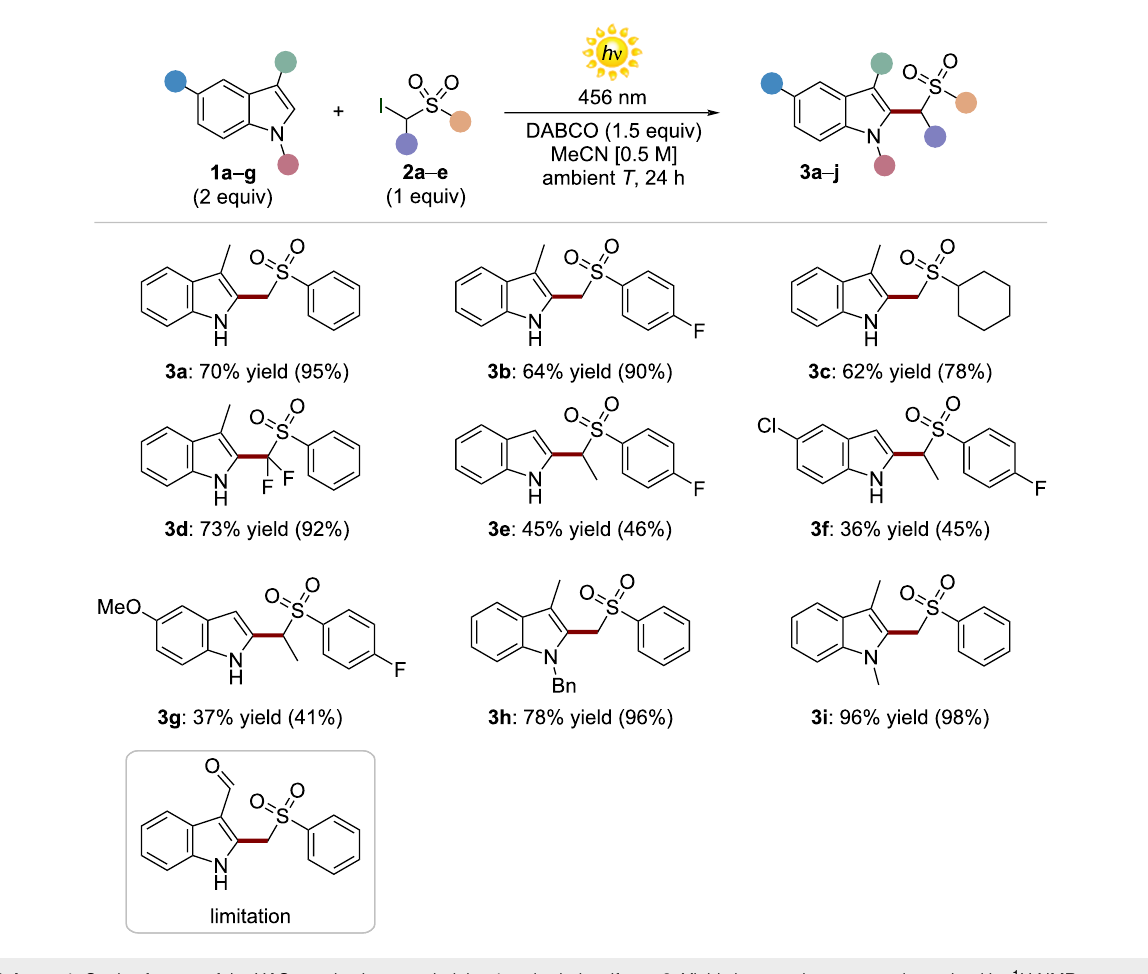
Scheme 1: Study of scope of the HAS reaction between indoles 1 and α -iodosulfones 2 . Yields in parentheses were determined by 1 H NMR analyses, using 1,3,5-trimethoxybenzene as an internal